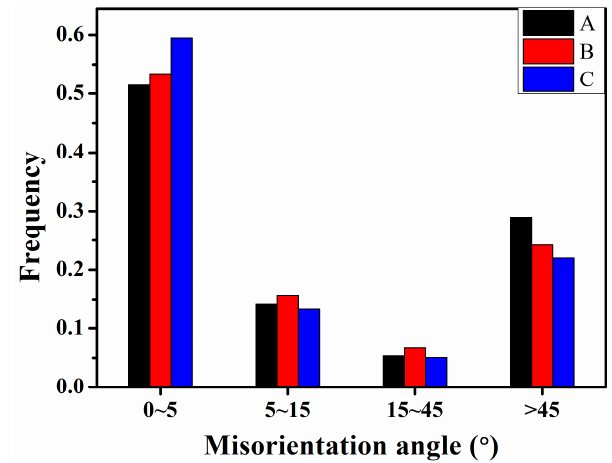
11 of 20 Figure 8. KAM map of specimen A ( a ), specimen B ( b ), specimen C ( c ), and a randomly chose en ‐ larged KAM map superposed with boundaries of specimen A ( d ), wherein the black line depicted the boundaries between 2° to 15° and the white line represented the boundaries over 15°. Figure 9. The statistics of the GND density.